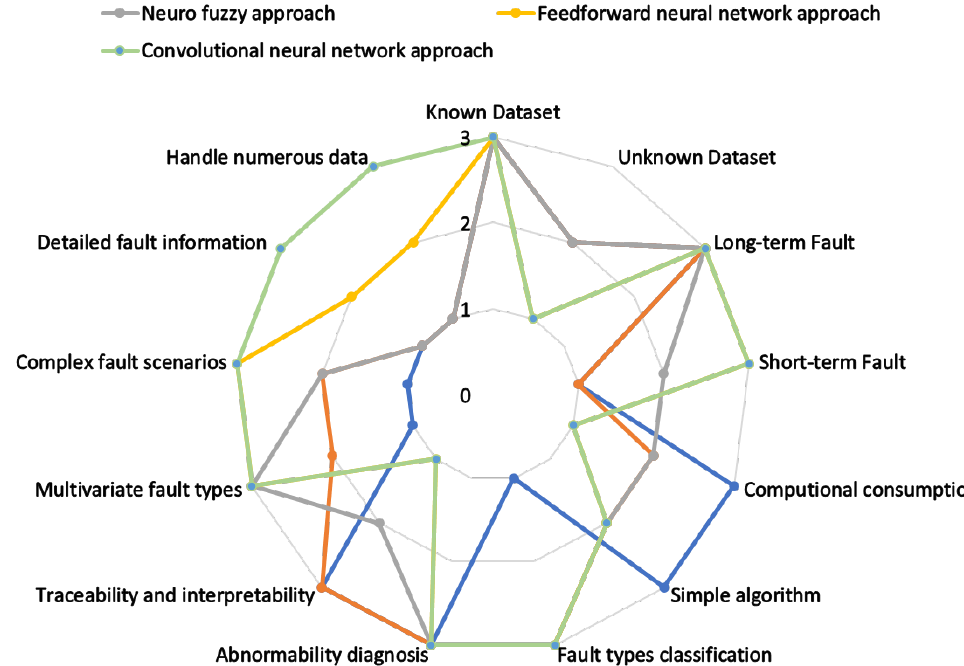
Figure 20. The ratings of the five fault diagnostic techniques for distinct attributes range from 1 (worst) to 3